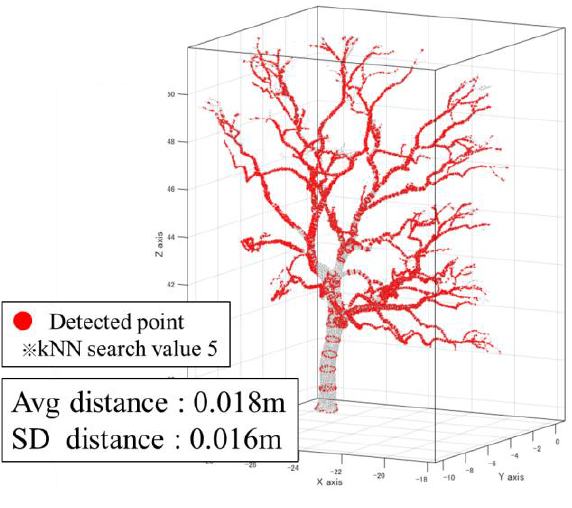
Figure 11. Whole tree accuracy results